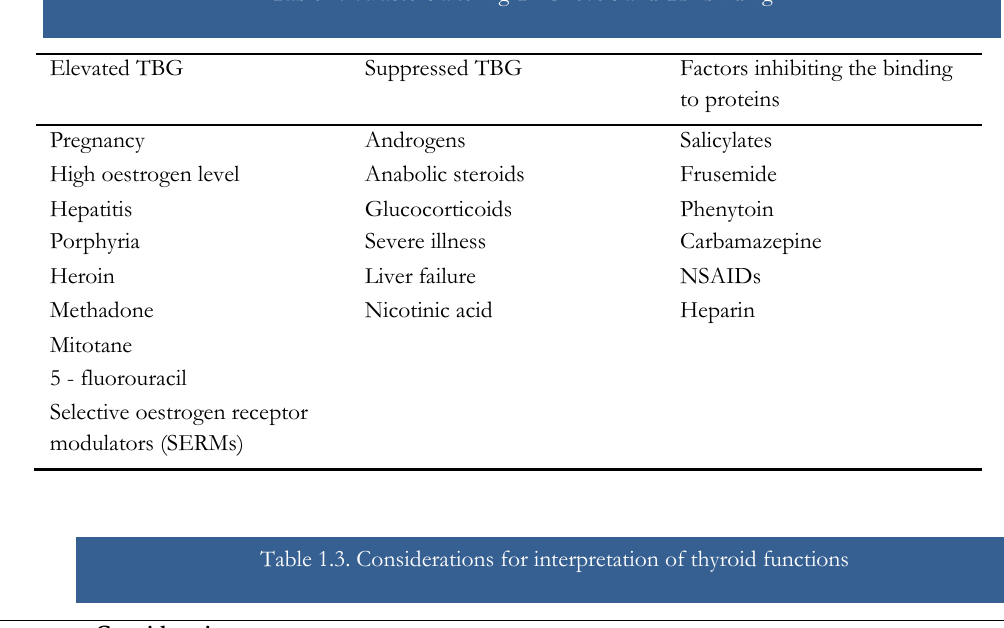
Table 1.2. Factors altering TBG levels and TH binding